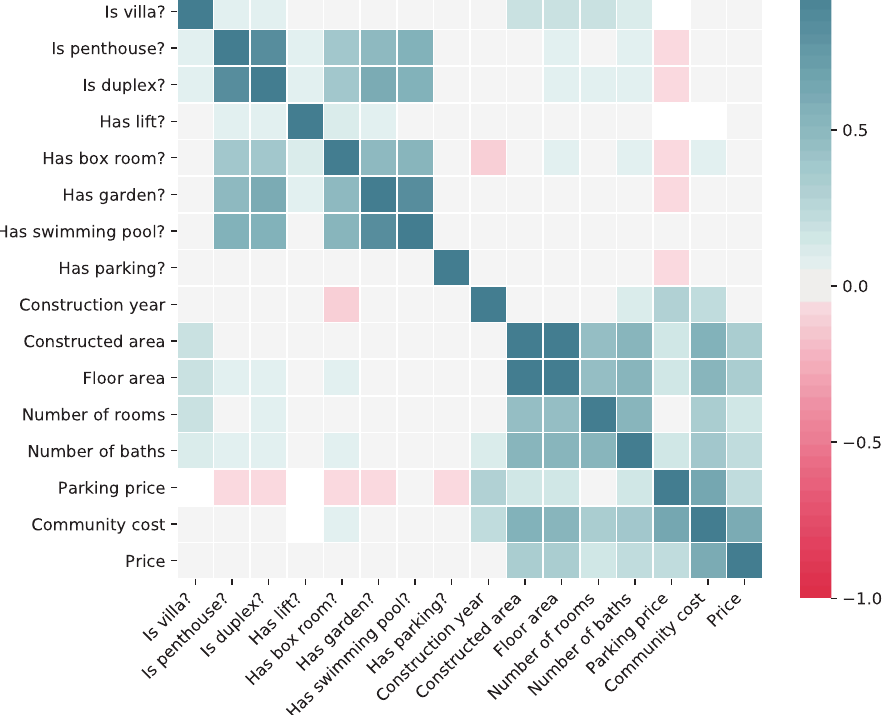
Figure 4. Matrix of correlations between each pair of